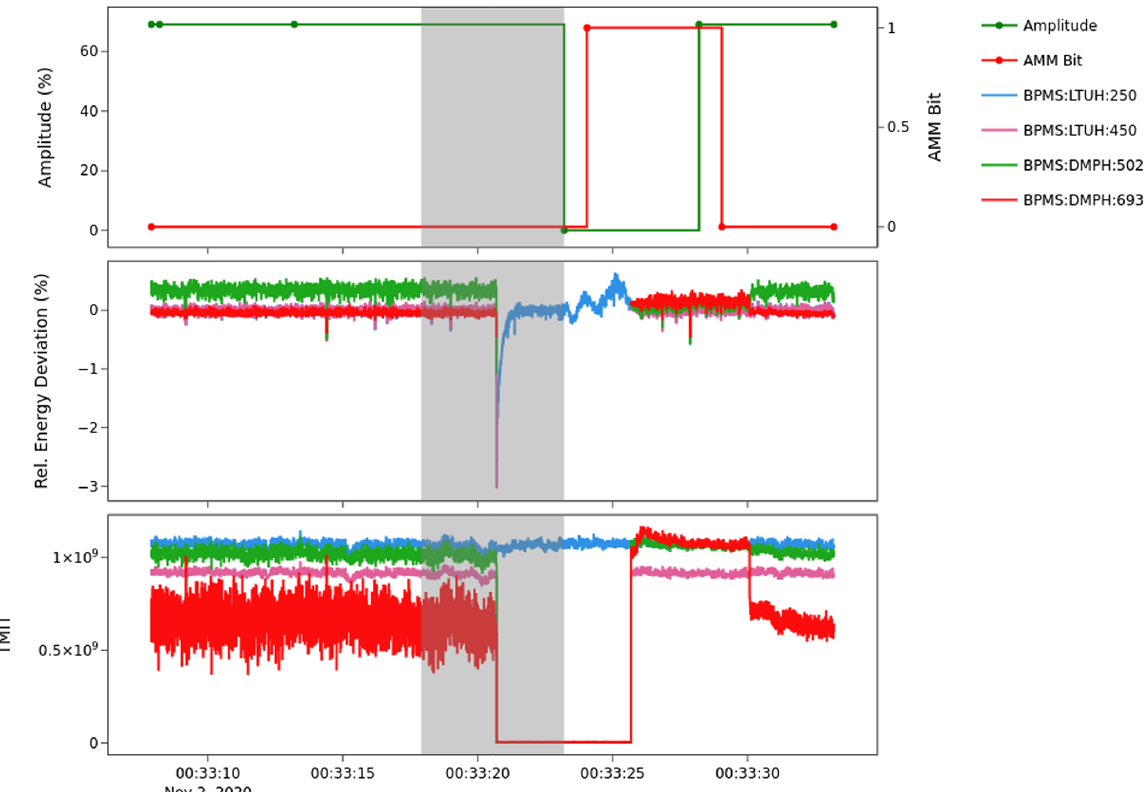
FIG. 4. Example of an rf station fault at KLYS:LI29:11. The top plot shows the klystron diagnostic data (both the AMM status bit and the AMPL signal). The middle plot shows the relative energy deviation (calculated from the beam position in the dispersive plane). The bottom plot shows the TMIT readings (which is the approximate number of electrons, subject to some calibration). The gray region defines the implied anomaly window, due to the delayed reporting of the klystron health information. This extreme example shows the AMPL drop nearly to 0, which causes the beam to be lost. The missing pulses in the energy deviation plot are the result of there being no beam to